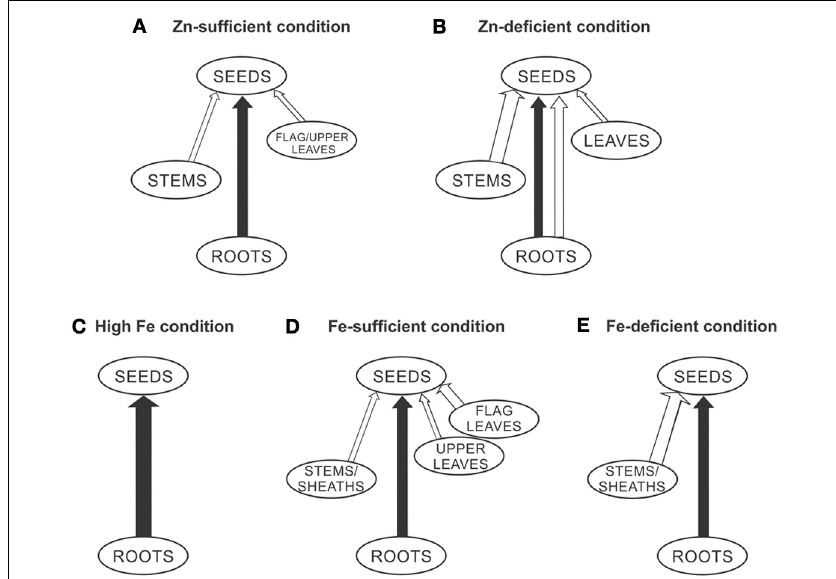
FIGURE 1 | Proposed model for Zn and Fe allocation to the rice seeds under different Zn and Fe supplies (A, Zn-sufficient condition; B, Zn-deficient condition; C, High Fe condition; D, Fe-sufficient condition; E, Fe-deficient condition), through the xylem (continued root uptake, black lines) and through the phloem (mineral remobilization, white lines). The thicknesses of the lines represent more or less active